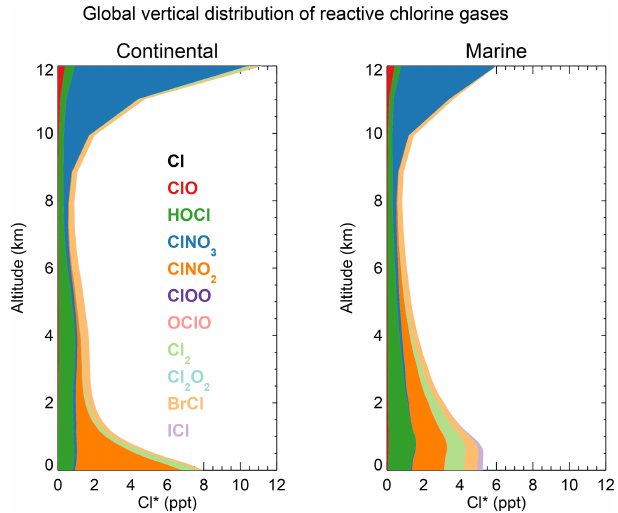
Figure 3. Global annual mean vertical distributions of reactive chlo- rine species (Cl ∗ ) in GEOS-Chem for continental and marine air. Stratospheric conditions are